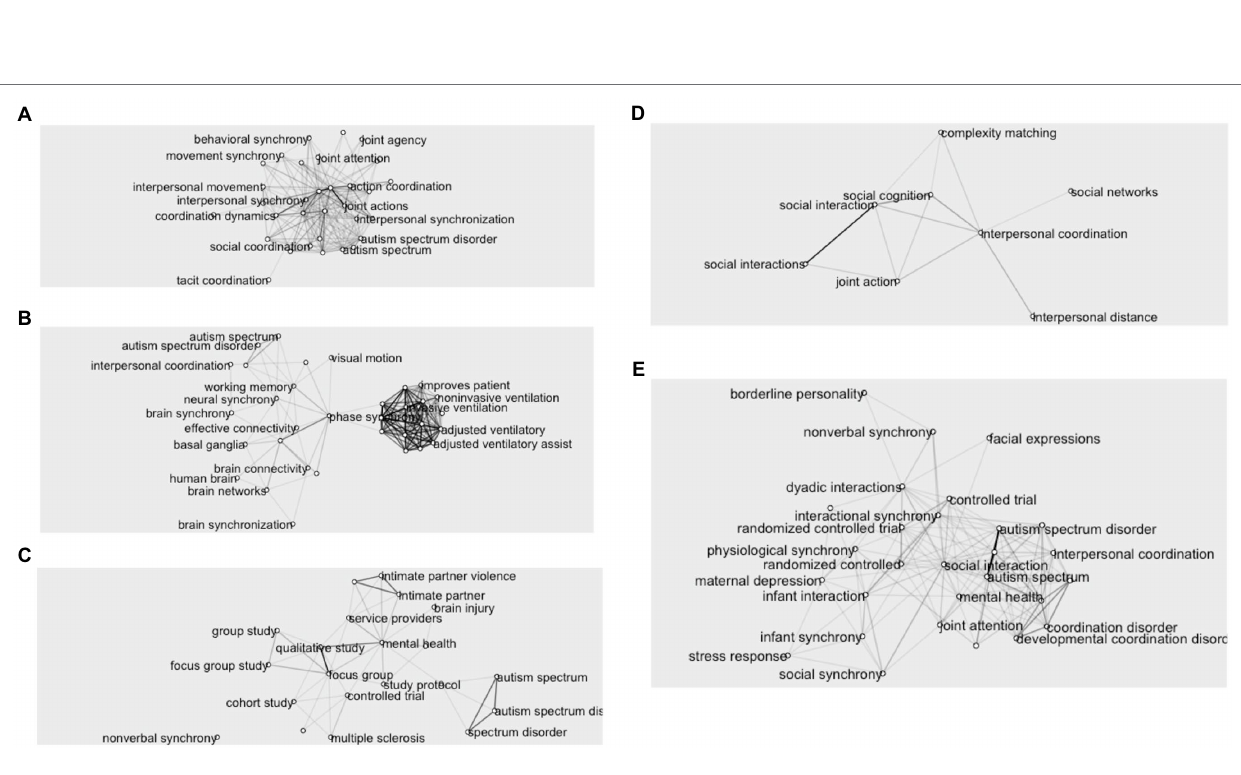
FIGURE 2 | Keywords network associated with the five topics (A-E)